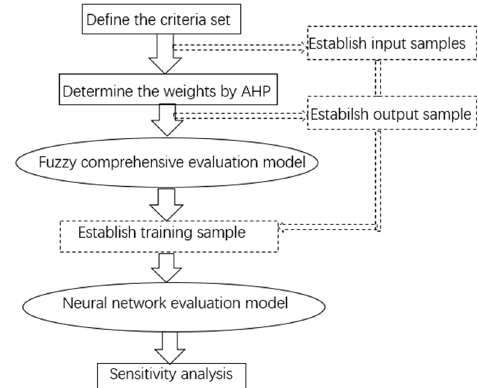
Fig. 3 Synthetic evaluation process of taxi industry health